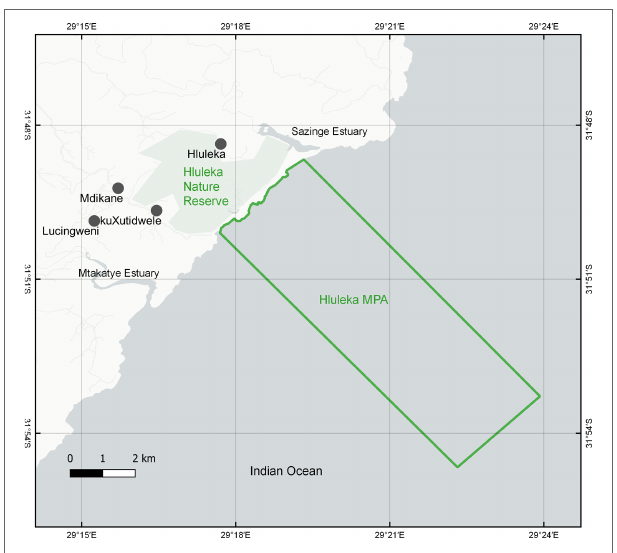
FIGURE 4 | Hluleka MPA (green border) and neighbouring communities (grey markers) are situated around the Hluleka Nature